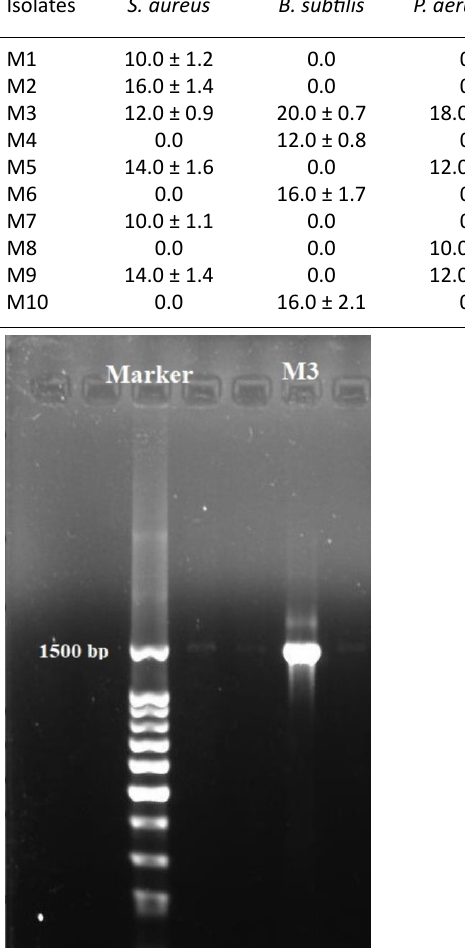
Inhibition zone (mm)